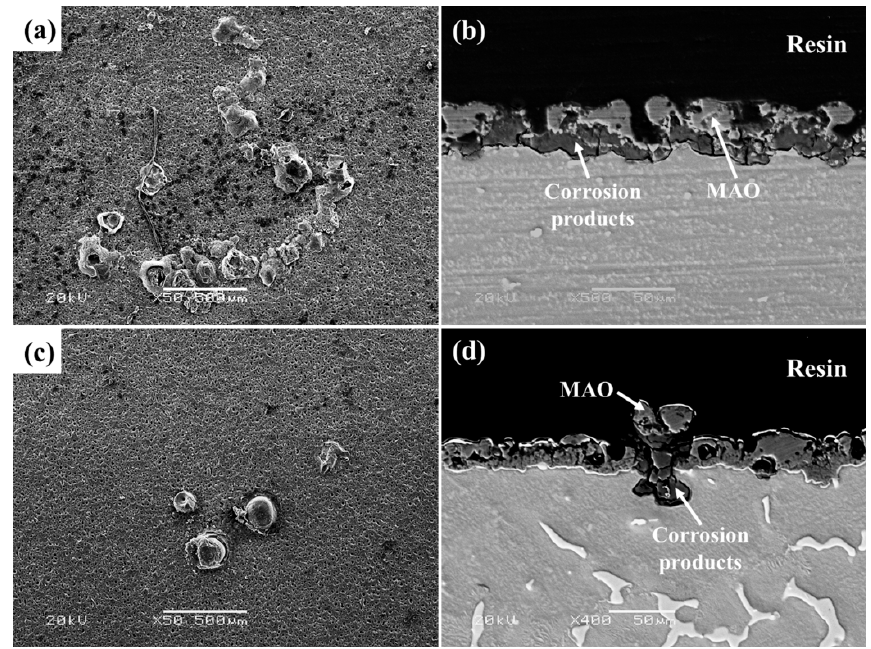
Figure 10. Surface and cross-section micrographs of the MAO-treated AZ31 ( a , b ) and AZ91 ( c , d ) alloys after 60 h immersion in 0.1 M NaCl solution.